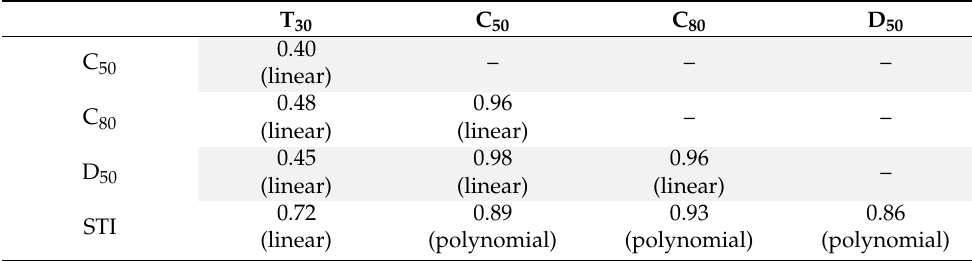
Figure 18. The best fit correlation among different acoustic simulated parameters. Table 7. The squared regression coefficient R2 and type of best fit